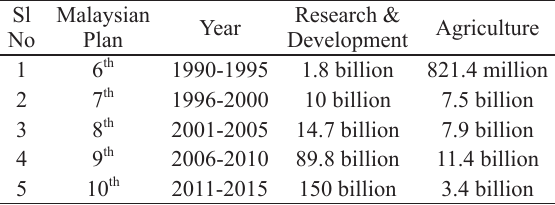
Comparative expenditure (RM) ratio between research & development (R&D) and Agriculture.